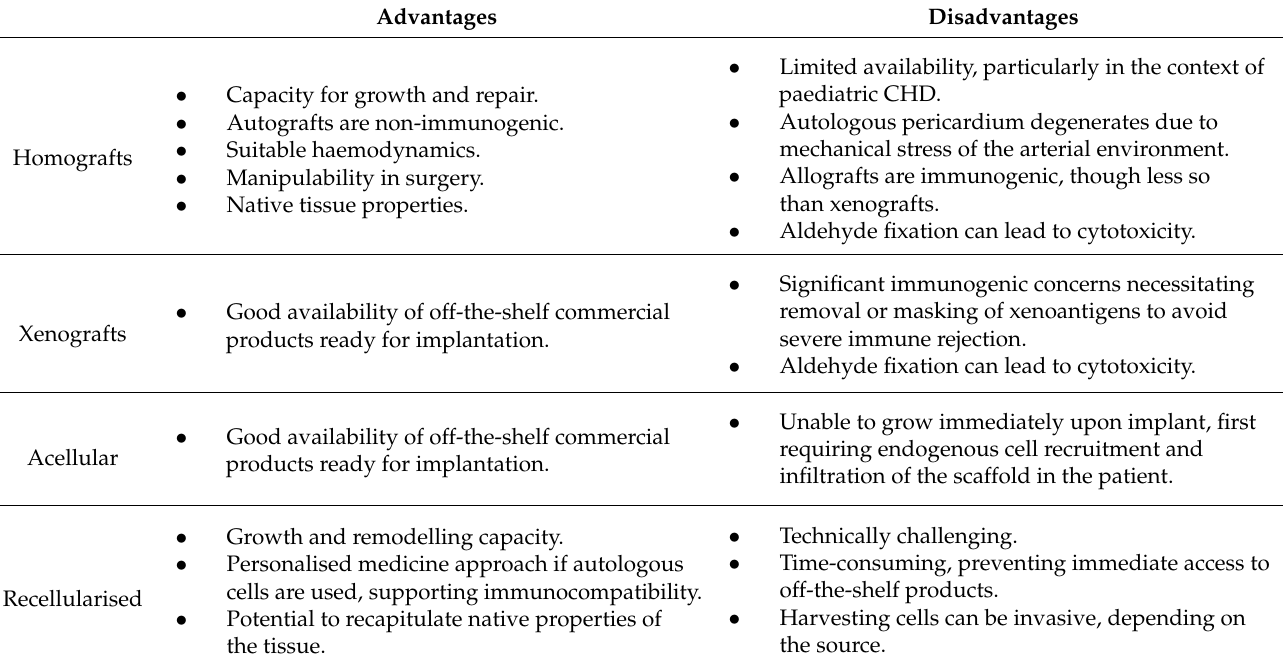
Table 1. Summary of the discussed advantages and disadvantages of homograft, xenograft, acellular, and cellular